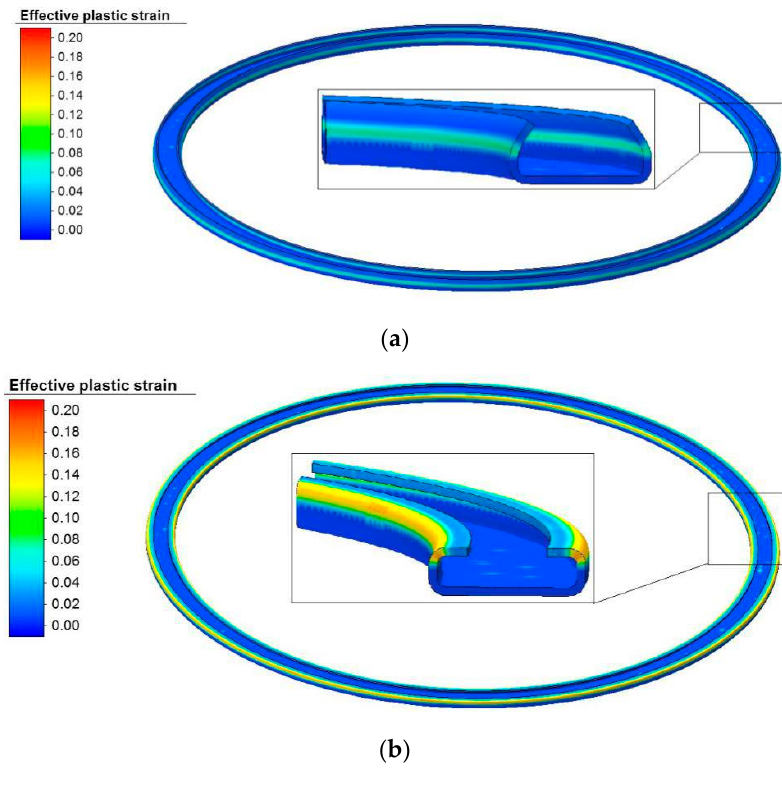
Figure 9. Strain field. ( a ) First pass; ( b ) second pass.